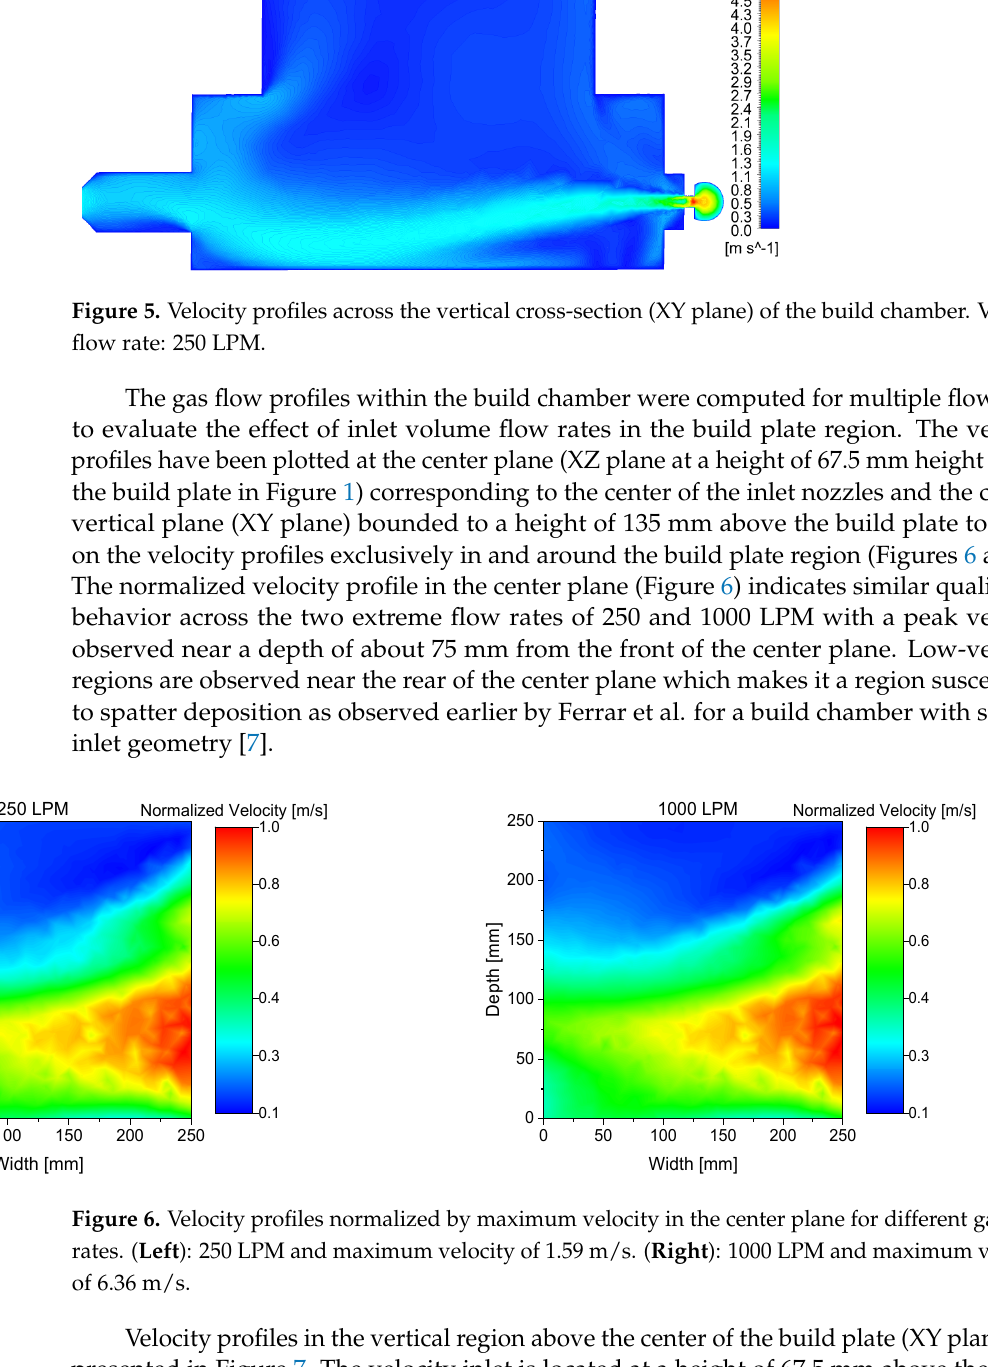
Figure 5. Velocity profiles across the vertical cross-section (XY plane) of the build chamber. Volume flow rate: 250 LPM.